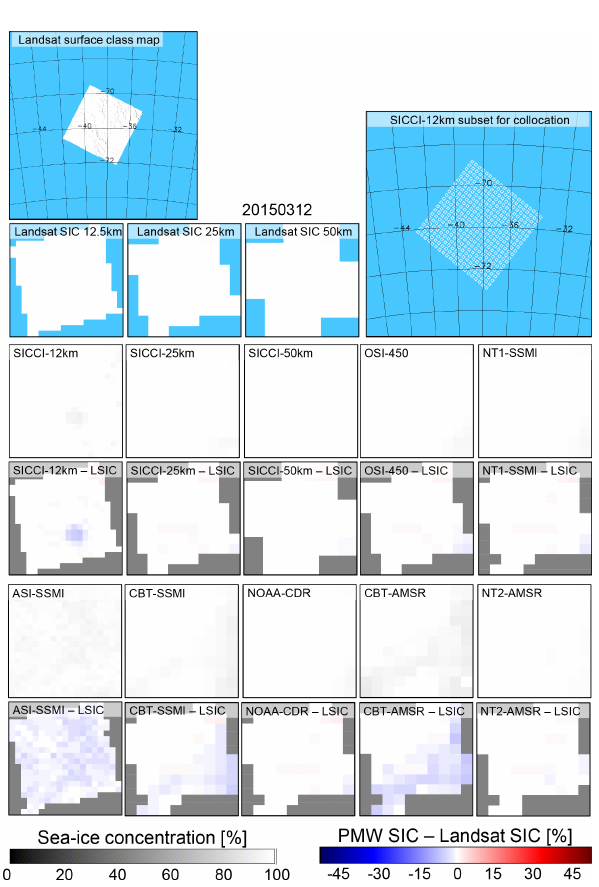
Figure 8. Landsat SIC, PMW SIC, and the difference PMW SIC mi- nus Landsat SIC for all 10 products for a high-concentration scene in the Weddell Sea, Southern Ocean, on 12 March 2015. See Fig. 5 for a description of the maps